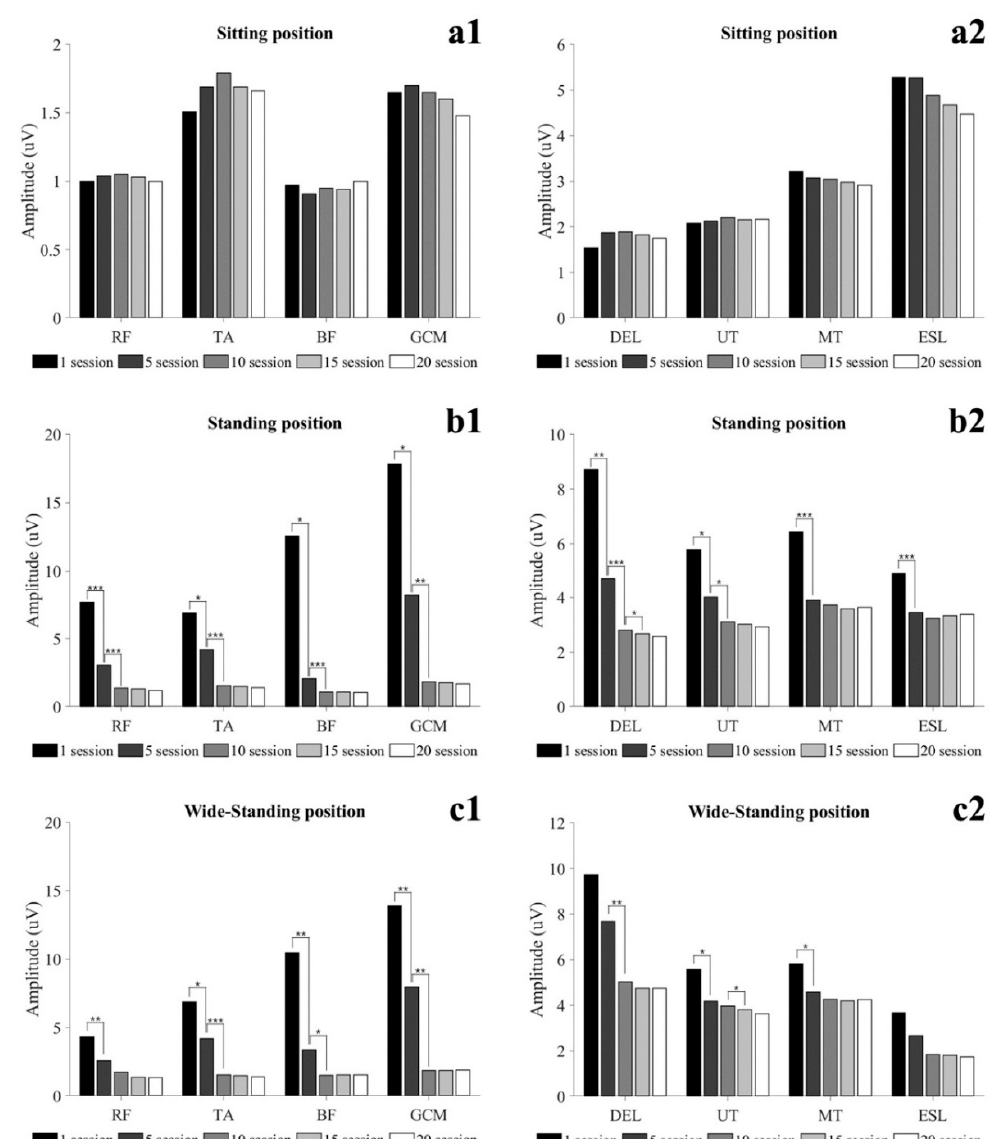
Figure 2. Changes in muscle activity in static condition during locomotion training. ( a1 ). Sitting (lower extremity muscles). ( a2 ). Sitting (trunk and shoulder muscles). ( b1 ). standing (lower extremity muscles). ( b2 ). standing (trunk and shoulder muscles). ( c1 ). wide-standing (lower extremity muscles). ( c2 ). wide-standing (trunk and shoulder muscles); * = p < 0.05, ** = p < 0.01, *** = p < 0.001. Abbreviation: RF, rectus femoris; TA, tibialis anterior; BF, biceps femoris; GCM, gastrocnemius; DEL, deltoid; UT, upper trapezius; MT, middle trapezius; ESL, erector spine lumbar.